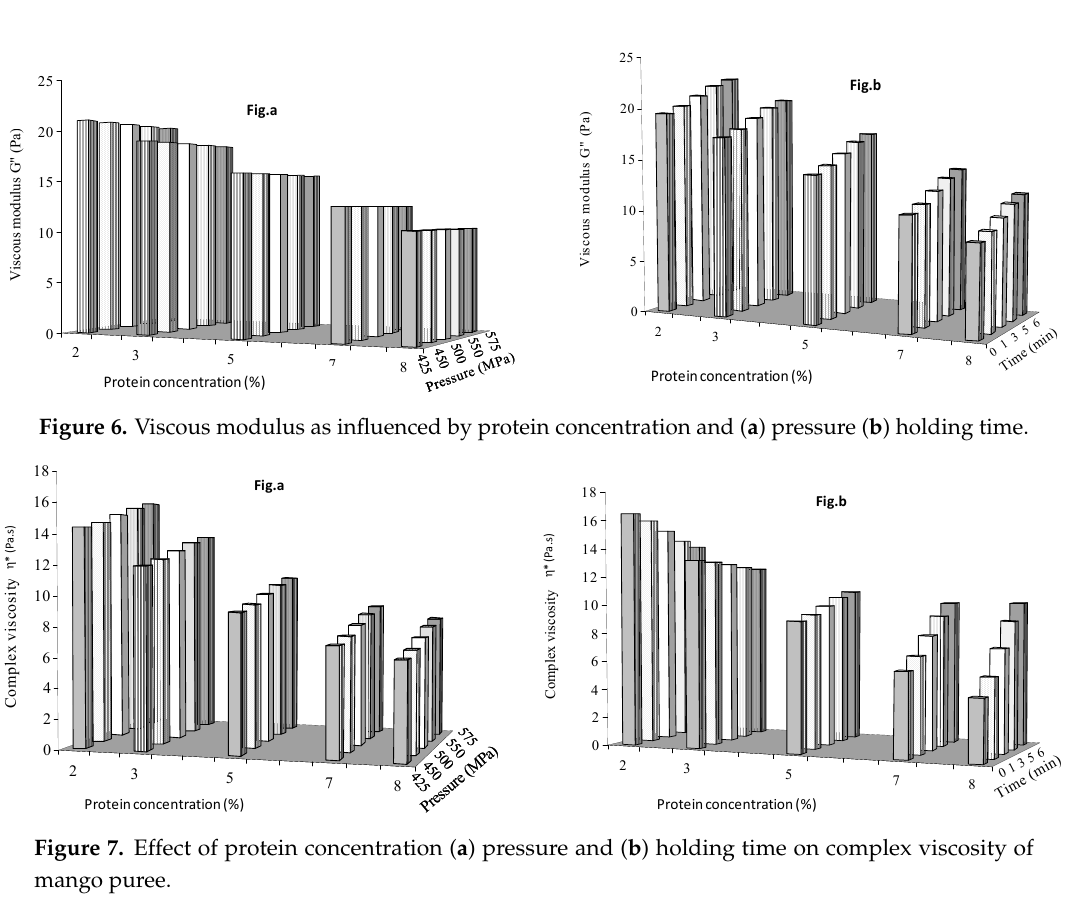
Figure 5. Elastic modulus as influenced by protein concentration and ( a ) pressure ( b ) holding time.